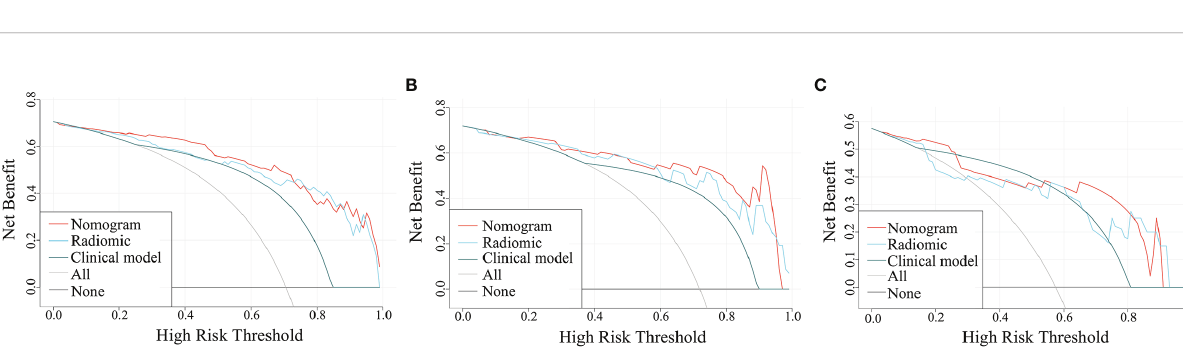
FIGURE 9 | Calibration curves of the combined model in the training (A) , testing (B) , and independent validation (C) cohort. The horizontal axis represents the prediction probability of the traditional combined with radiomics feature model, and the vertical axis represents the actual occurrence probability, both of which demonstrated good agreement between prediction and observation of the model.